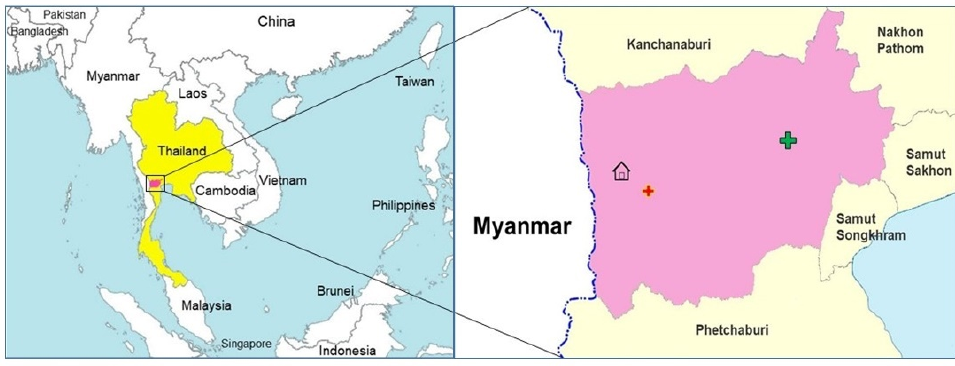
Figure 2. The map display of the patient’s house located in Suan Phueng District, Ratchaburi, Thailand, where the red and green crosses indicate the malaria post and district hospital, respectively.